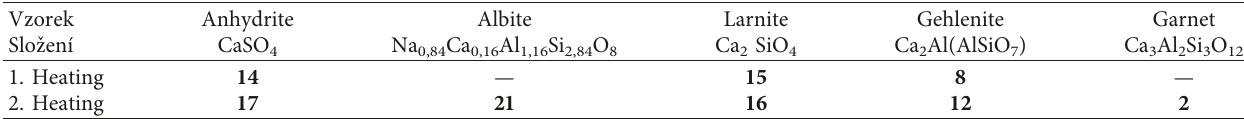
Figure 7: Comparison of DTA curves of the second heating. Table 5: Analysis of the crystalline phase after the 1st and 2nd heating.